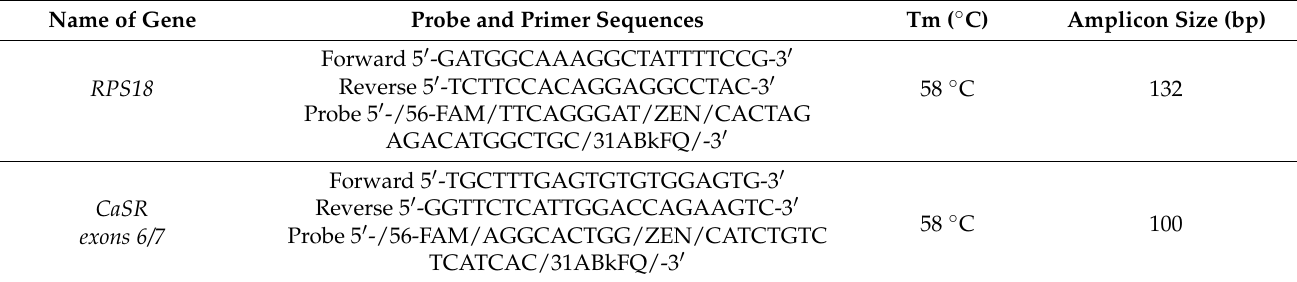
Table 3. List of the human gene-specific TaqMan probes and primers used in the analysis. TaqMan probes with F as reporter fluorochrome (6-carboxyfuorescein [6-FAM]) and ZEN as quencher. Fluorochrome (Iowa Black FQ). Name of Gene Probe and Primer